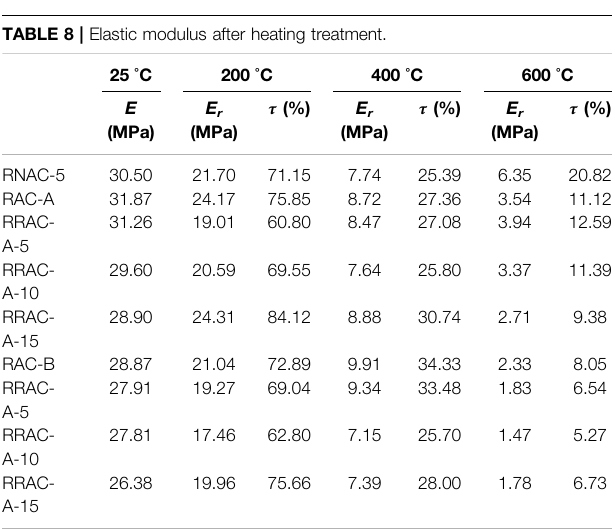
TABLE 8 | Elastic modulus after heating treatment.